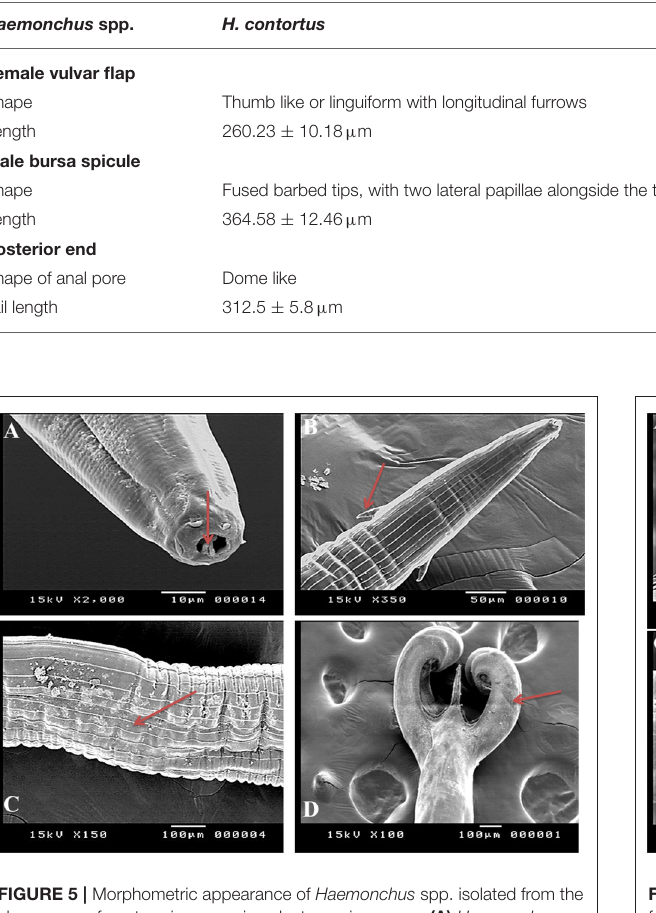
FIGURE 5 | Morphometric appearance of Haemonchus spp. isolated from the abomasum of goats using scanning electron microscopy. (A) Haemonchus spp. showing the buccal capsule containing a lancet (arrow). (B) Haemonchus spp. showing a cervical papilla-like spine (arrow). (C) Haemonchus spp. showing longitudinal cuticular ridges (arrow). (D) The tail region of male Haemonchus spp. showing a copulatory bursa (arrow).